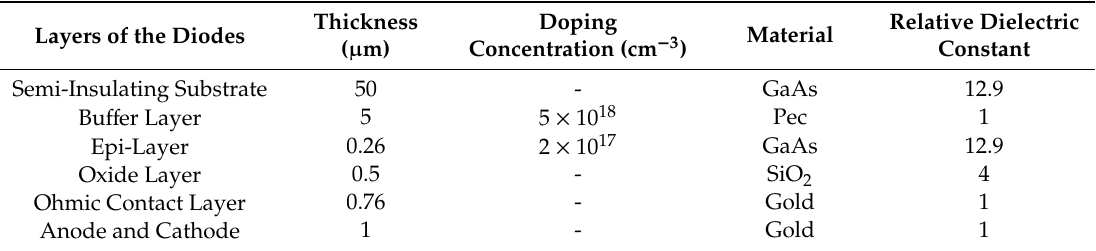
Table 1. Layer Structure Parameters of the diodes used in this paper.